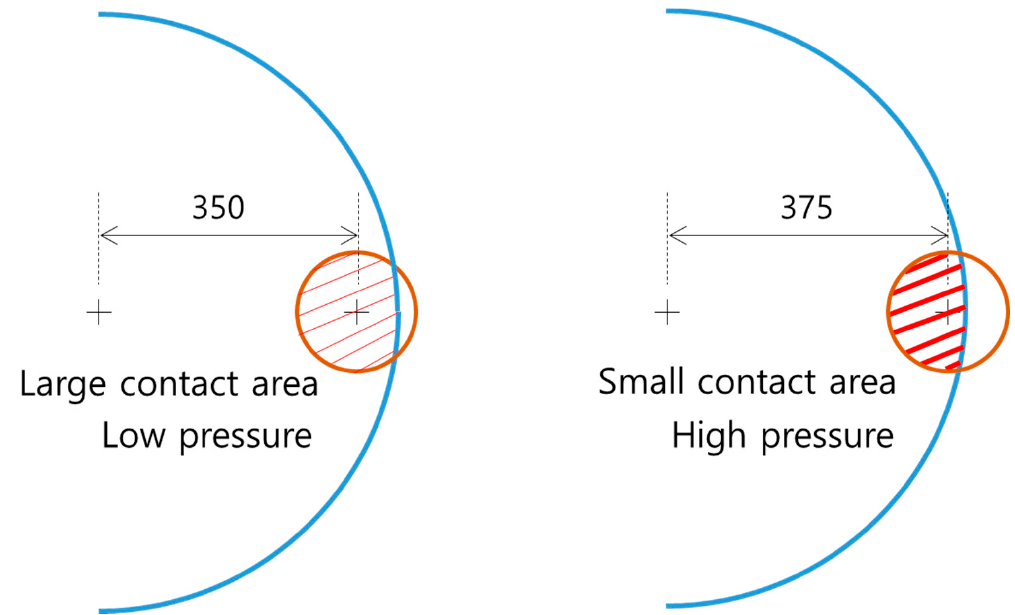
Figure 11. Schematic of the change in the contact area and pressure with respect to the overhang length (350 mm and 375 mm).